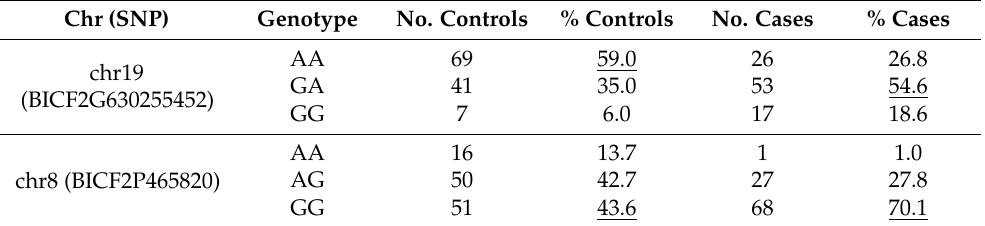
Table 2. Genotypes of the two top SNPs from the case/control GWAS for chromosomes 19 and 8. The highest proportions in each phenotype group are